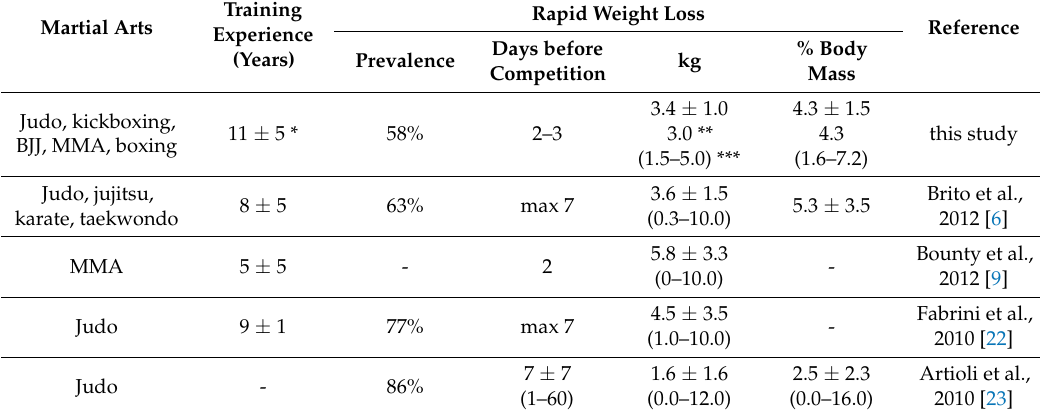
Table 3. Rapid Weight Loss Prevalence and Magnitude in Combat Sports’